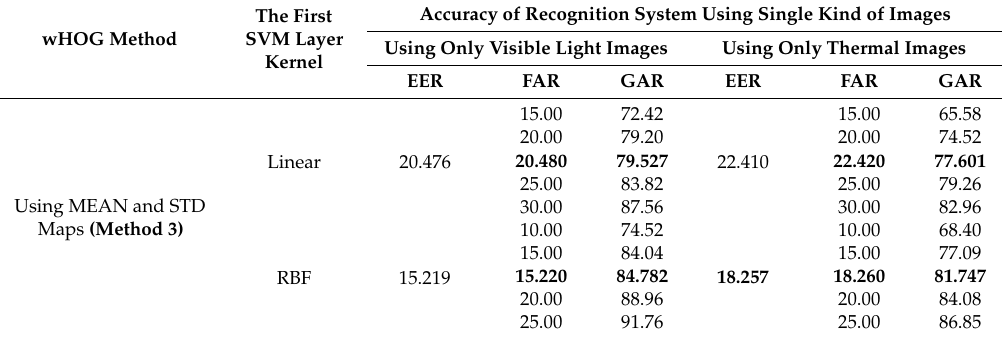
Table 8. Recognition accuracies of our proposed method (using the MEAN map for quality assessment of image regions of visible light images and the STD map for quality assessment of image regions of thermal images) using single kind of images (unit: %).